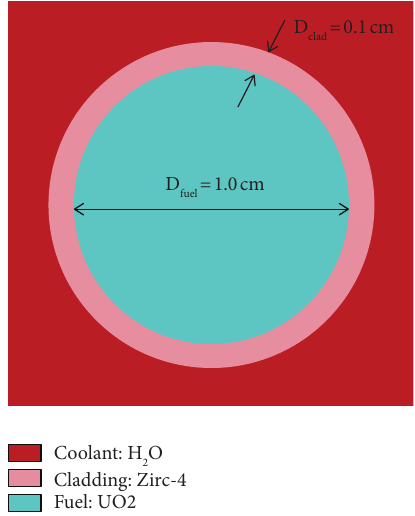
Figure 3: Schematic of the single PWR